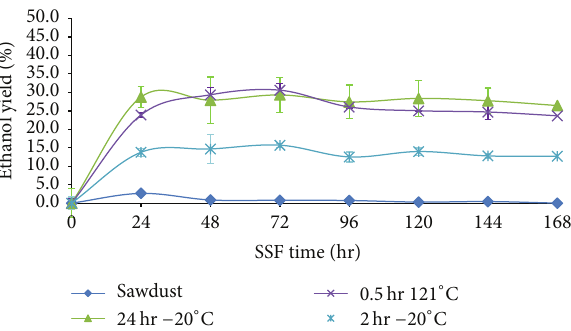
Figure 4: Ethanol yield from sawdust samples pretreated with 7% NaOH at 121 ∘ C and − 20 ∘ C using SSF system with 20.0 FPU / g TS cellulase.